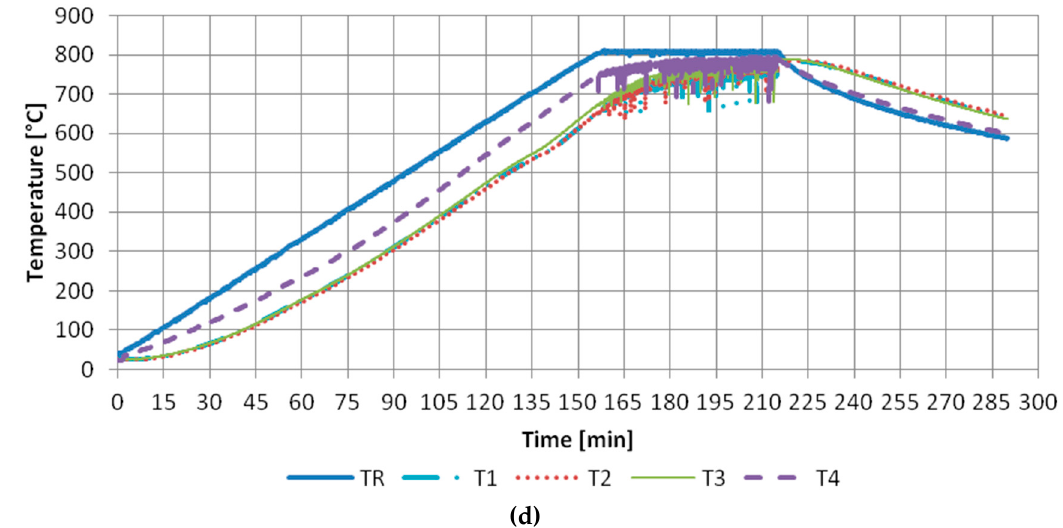
Figure 5. Heating curves. Temperature distribution in pilot sample for concrete composite B5: ( a ) 200 °C, ( b ) 400 °C, ( c ) 600 °C, ( d ) 800 °C.